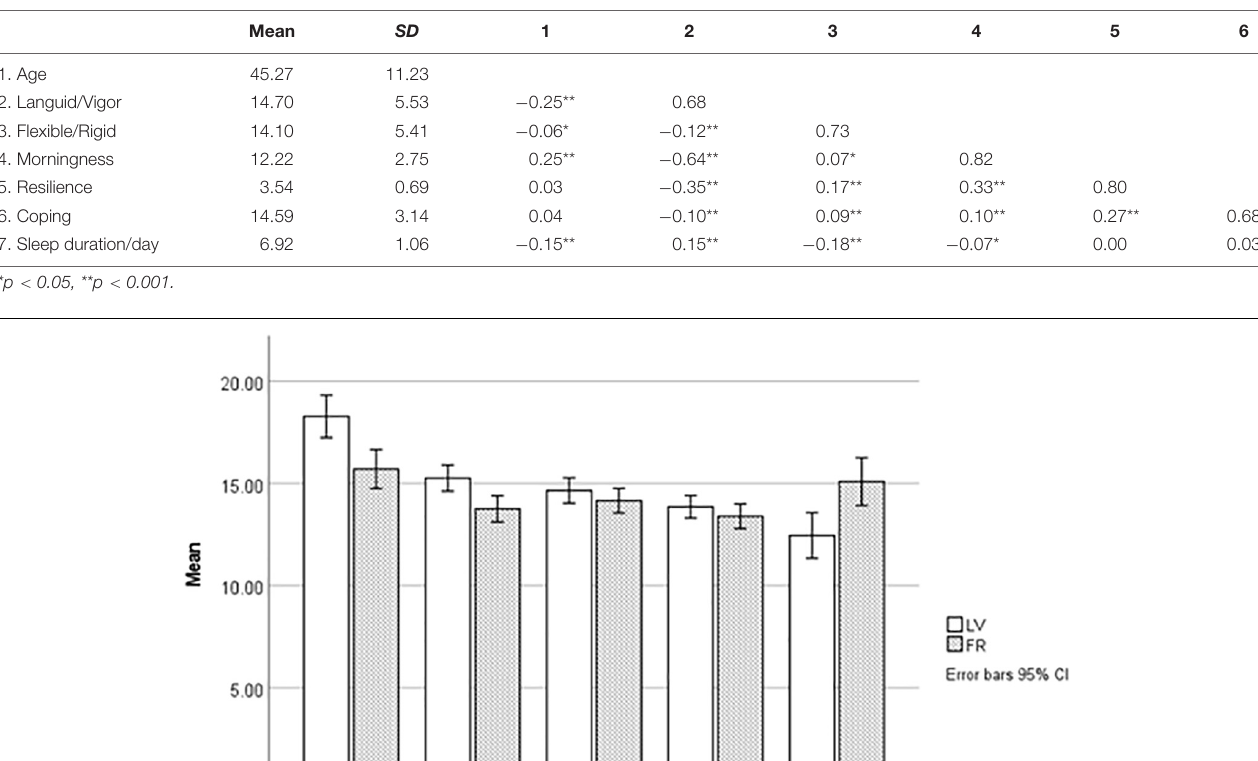
TABLE 1 | Descriptive statistics, correlations, and Cronbach alpha (diagonal) for scale scores.